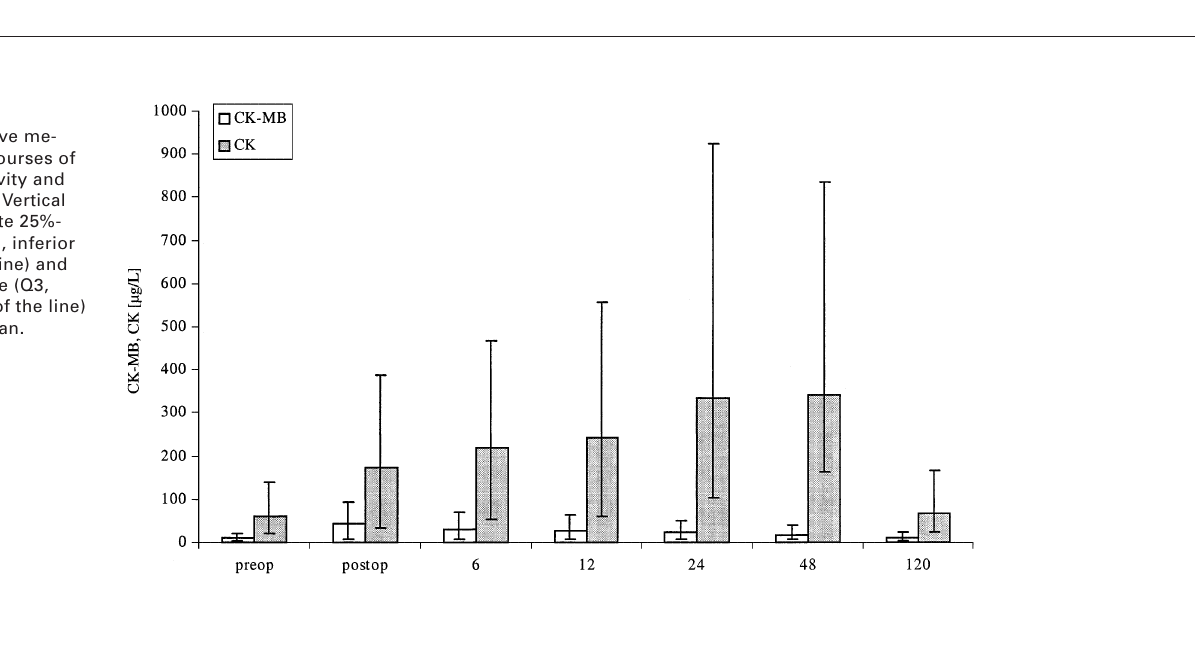
Table 2 95%-confidence limits based on the median for cTnI [µg/L], cTnT [µg/L], CK-MB-activity [U/L] and CK-activity [U/L].